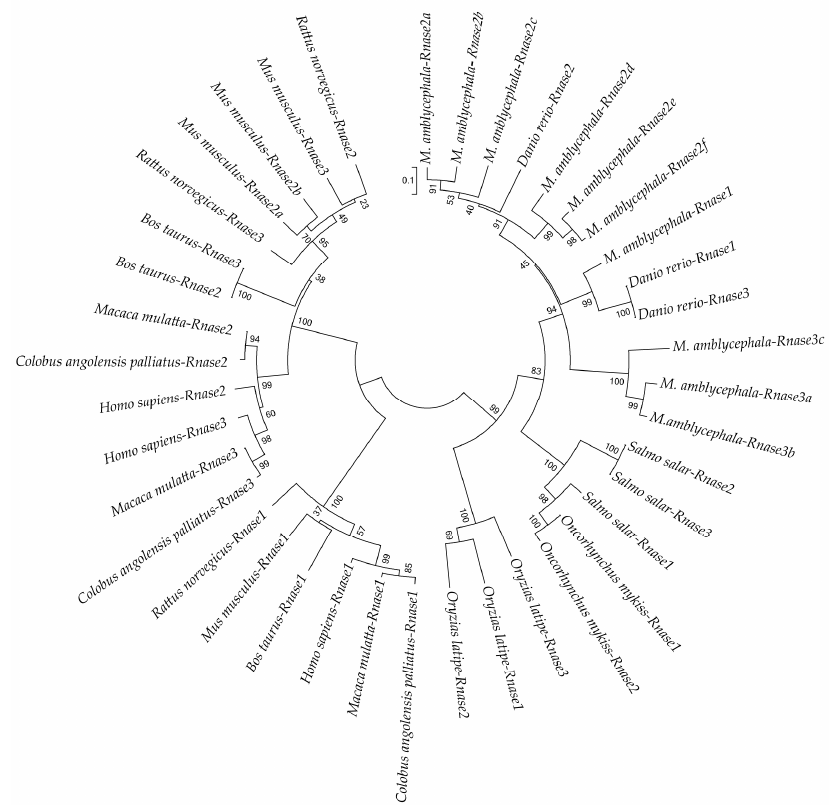
Figure 3. Neighbor-Joining (NJ) phylogenetic tree showing the relationships among protein sequences of Rnase1 , 2 and 3 of various bony fishes and mammals. Numbers at the branches indicate bootstrap probabilities inferred with 1000 replicates.